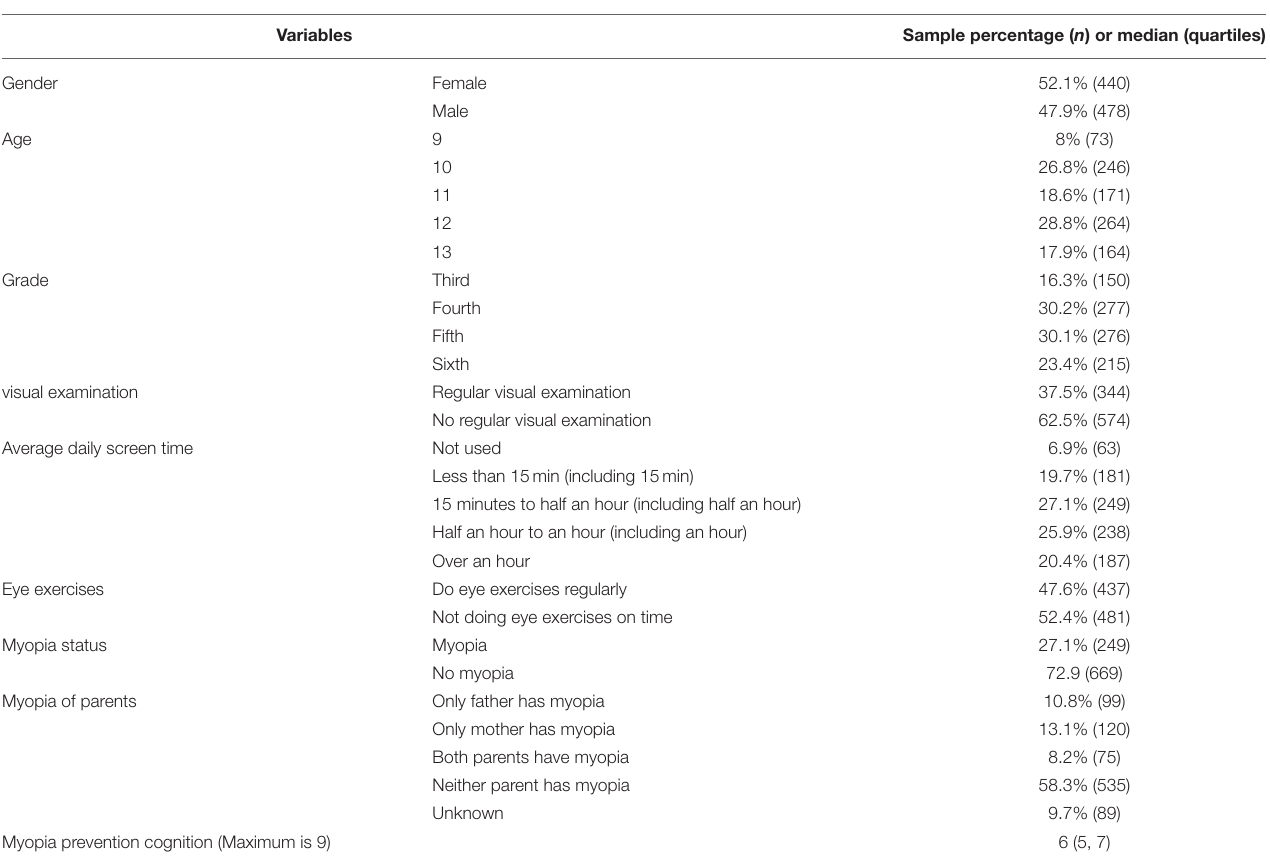
TABLE 2 | Demographic characteristics of children ( n =